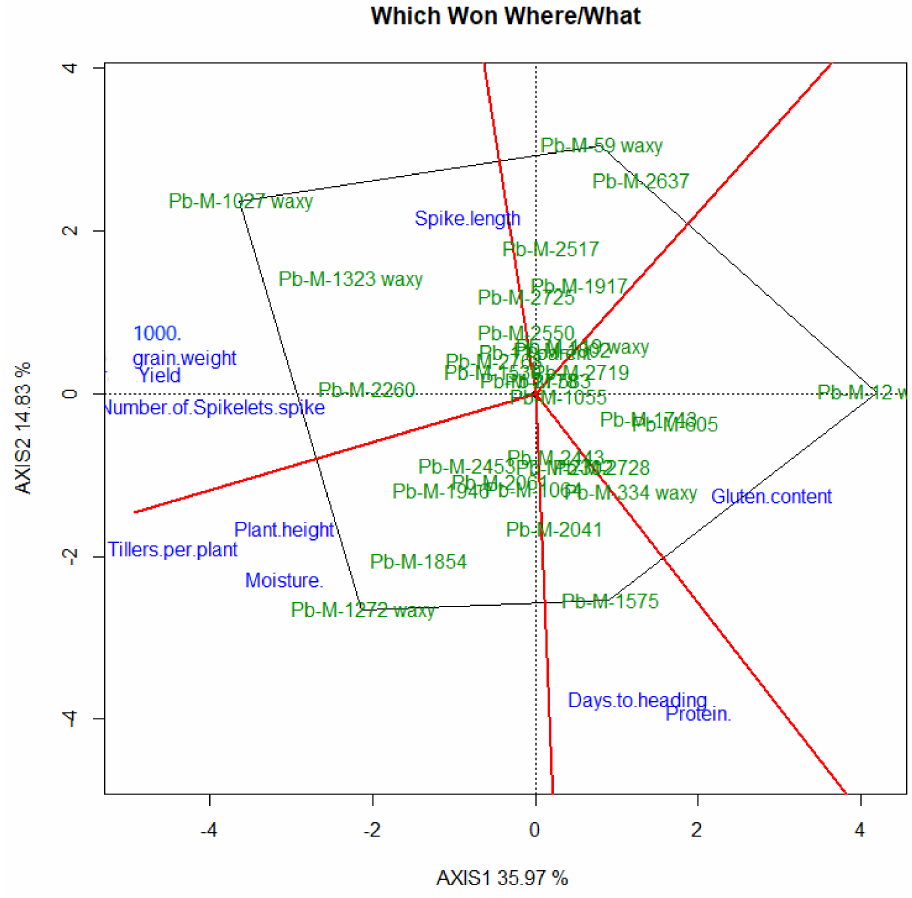
Figure 9. Polygon view of the GT bi-plot of 32 mutant lines and the wild type at the NIBGE